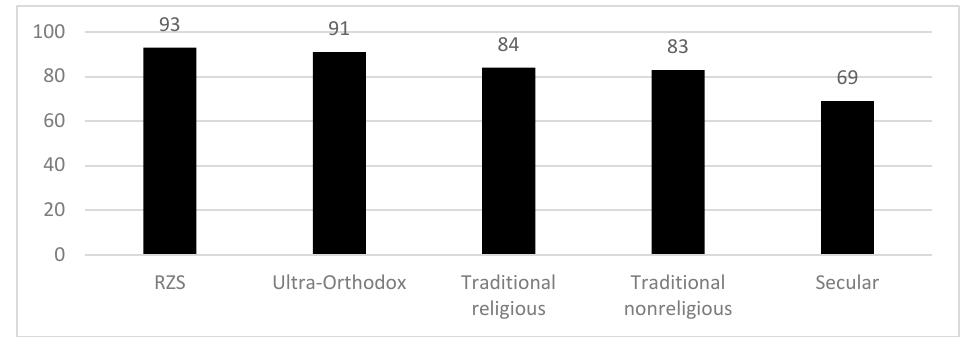
Figure 3. Agree that Israel is a good place to live, by level of religiosity (%) (Source: Israeli Democracy Index, 2014 ‒ 2021).